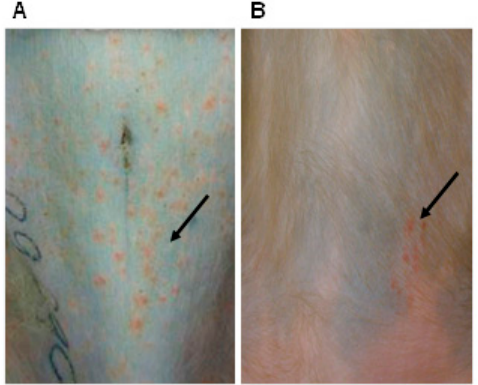
Figure 5. Varicella and zoster rash in non-human primates (NHP). ( A ) A hemorrhagic varicella rash in an African green monkeys (AGM), 13 days post-intratracheal inoculation and ( B ) a zoster rash in a latently infected rhesus macaques (RM), seven weeks after immunosuppression. Arrows indicate the location of rash on the skin.